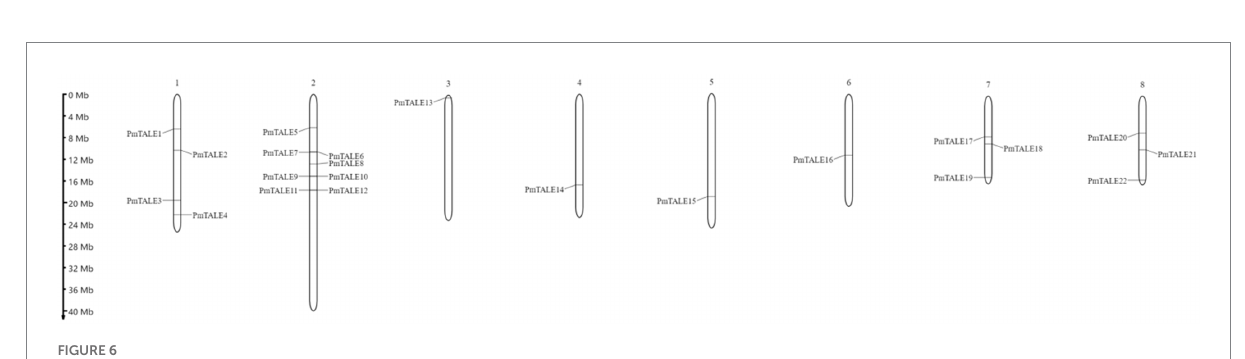
expansion of members of the TALE gene family in P. mume (Figure